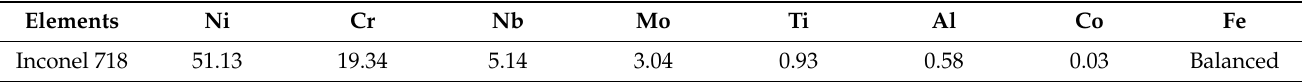
Figure 1. Morphology ( a ) and size distribution ( b ) of Inconel 718 powder. Table 1. Chemical composition (wt. %) of the Inconel 718 powder.